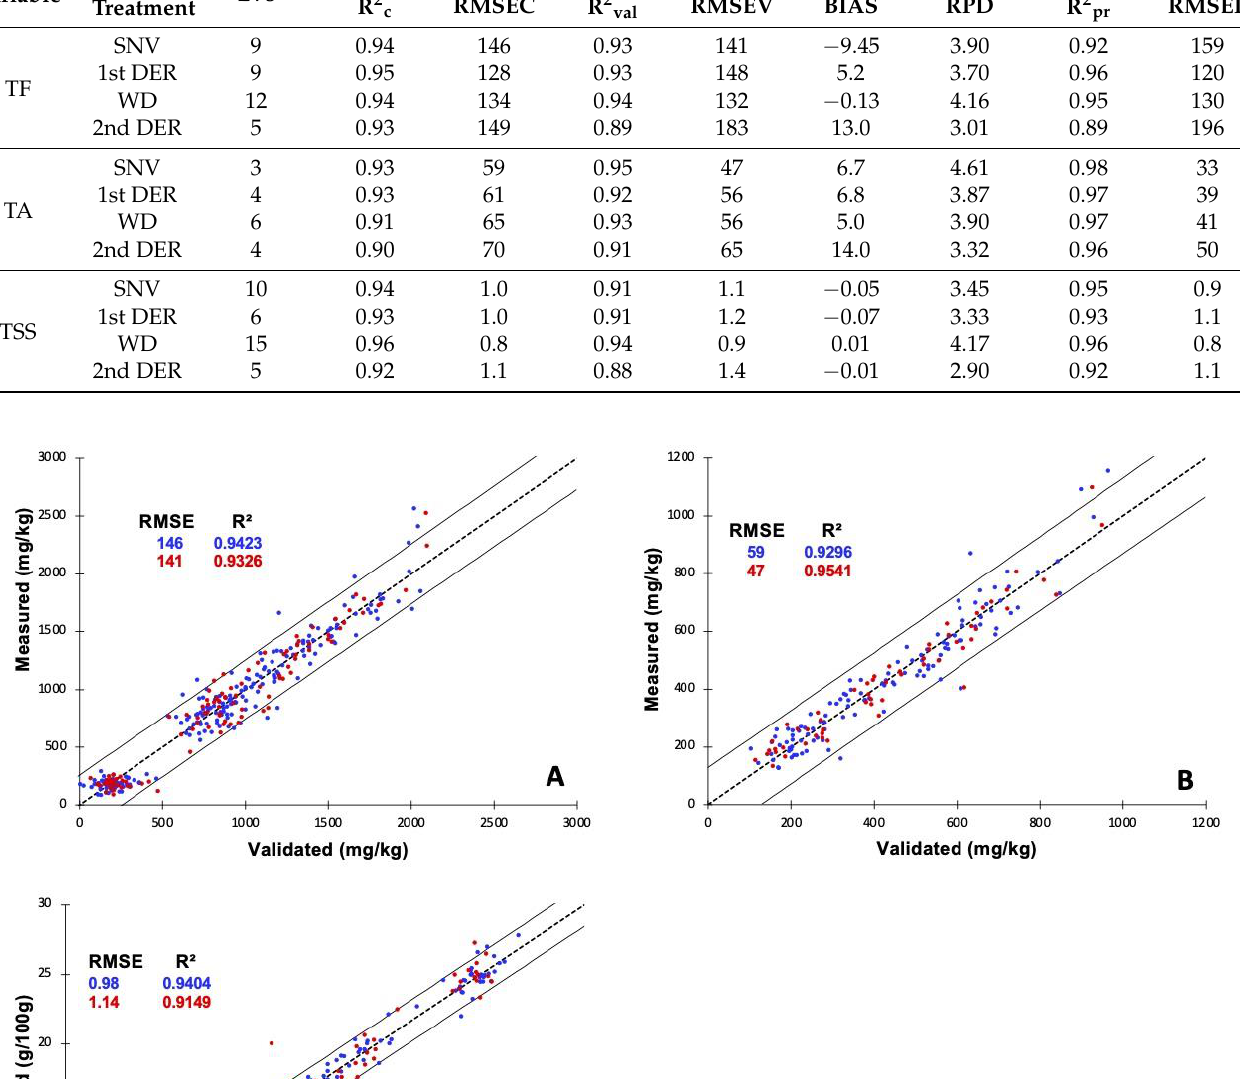
Table 2. Performance of partial least square (PLS) models depending on data pre-treatments for predicting TF, TA, and